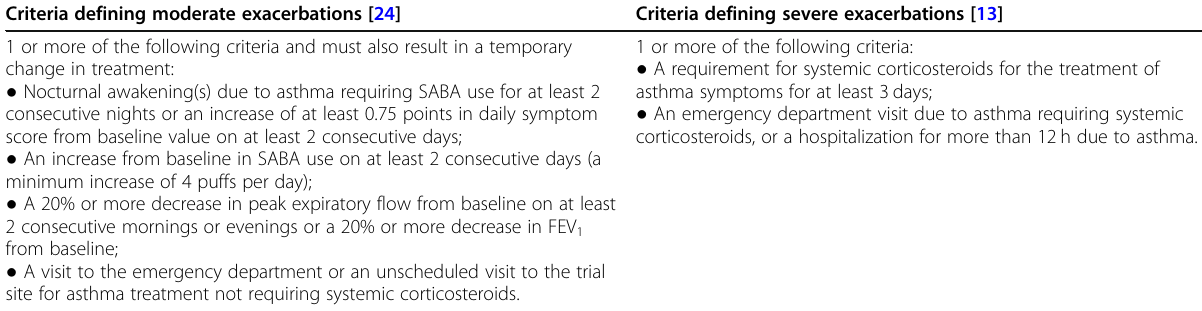
Table 1 Definitions of moderate and severe exacerbations used in the MT-04 trial Criteria defining moderate exacerbations